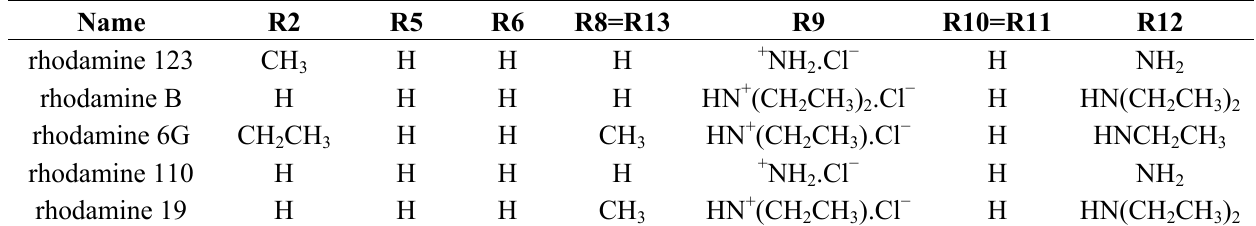
Table 7. R-groups within a series of rhodamine derivatives.